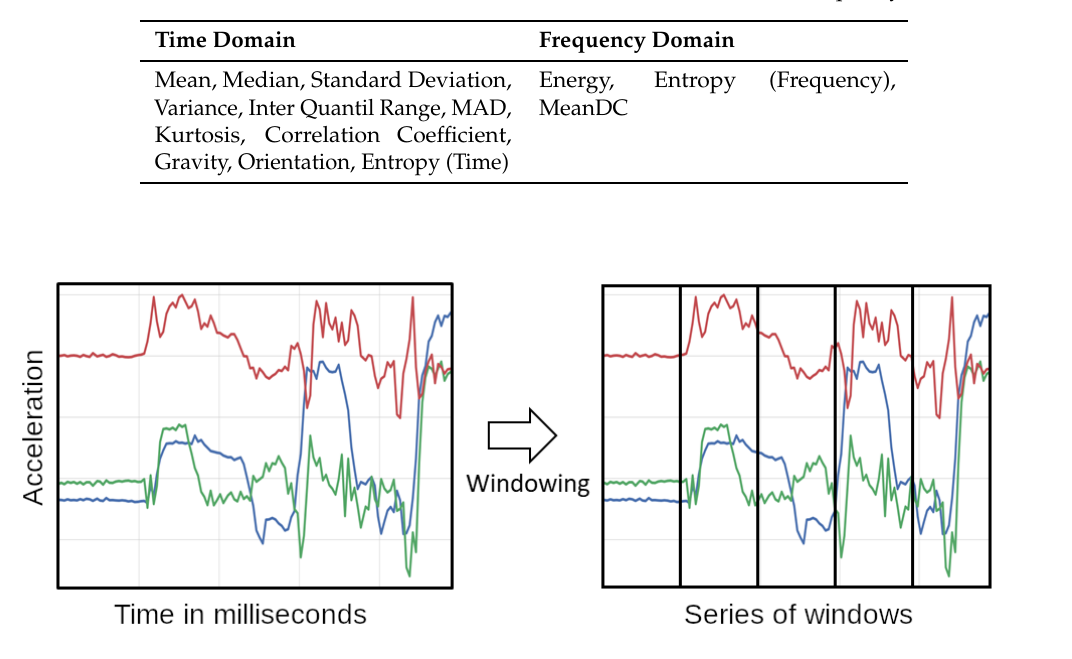
Table 1. Set of features from acceleration data. Features are in the time and frequency domain.